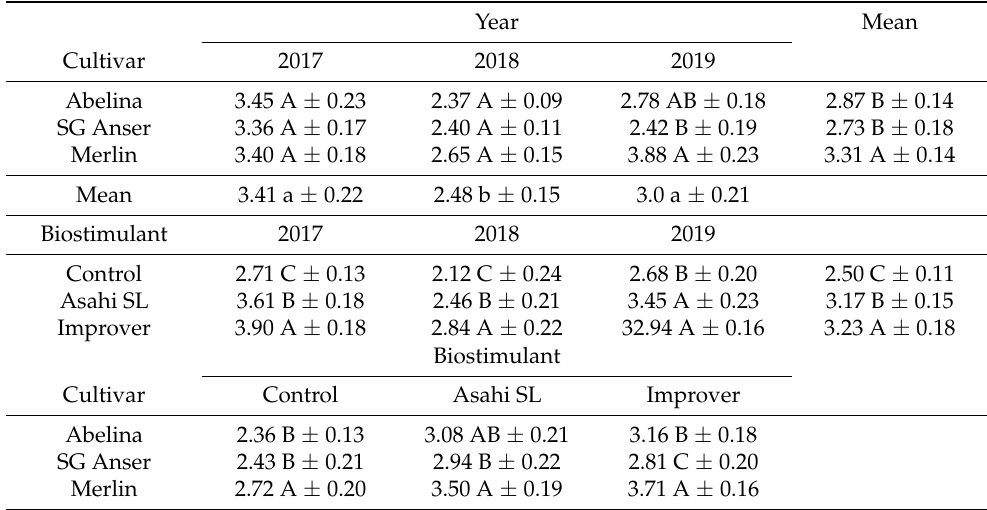
Table 3. Soybean yield performance according to years, cultivars, and biostimulants (Mgha − 1